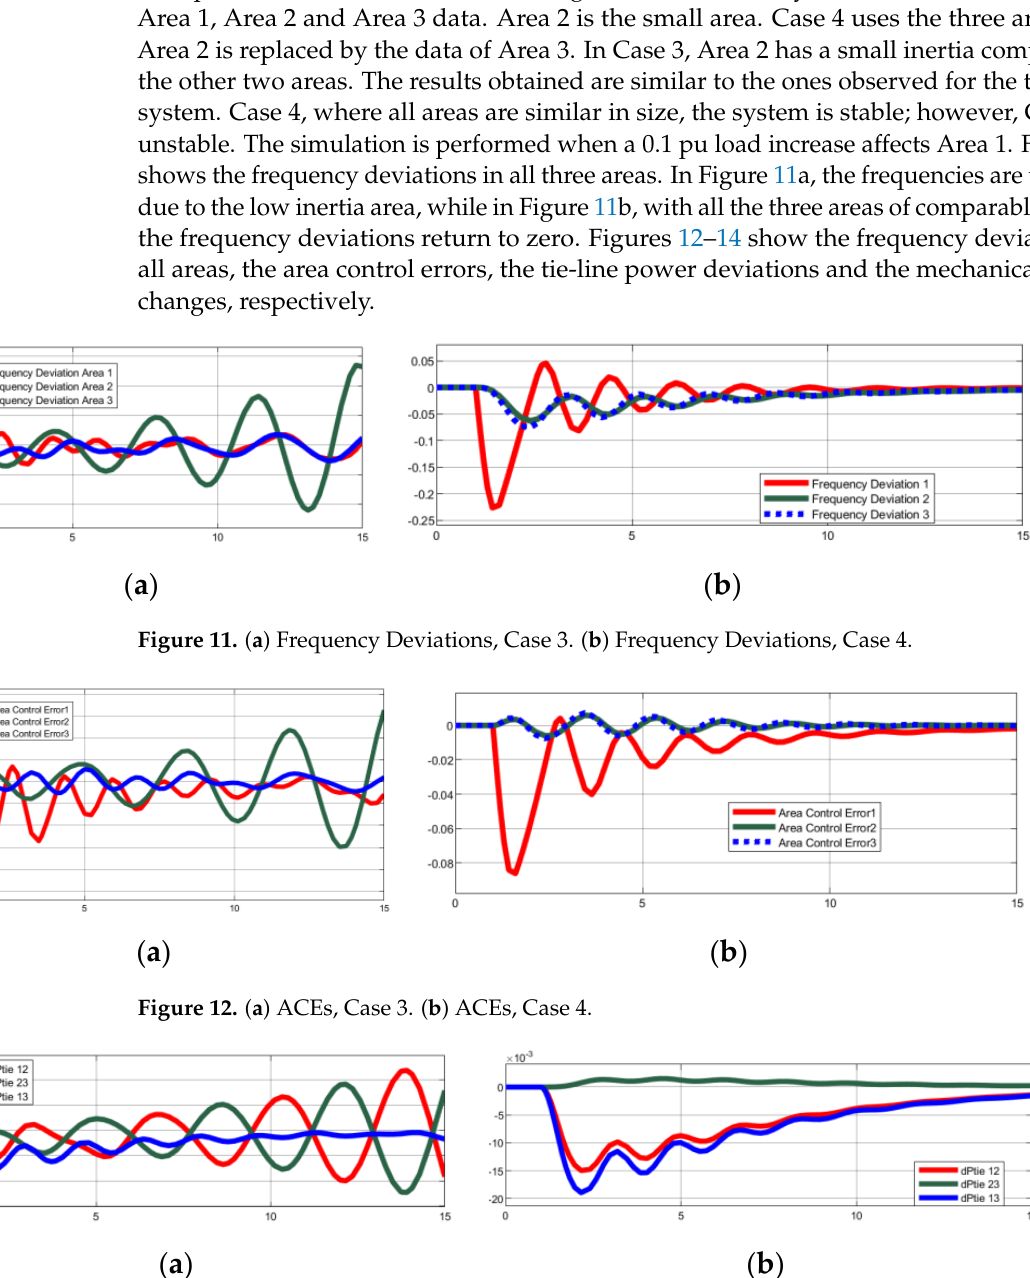
Figure 12. ( a ) ACEs, Case 3. ( b ) ACEs, Case 4.